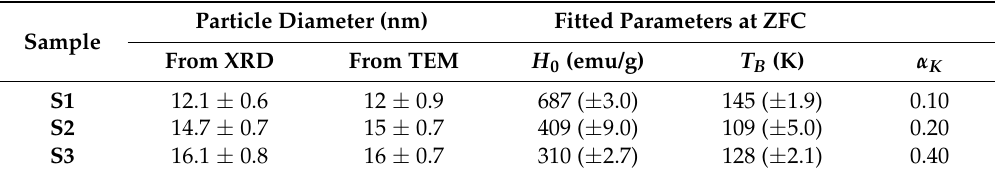
Table 1. The fitted magnetic parameters to the modified Kneller’s law.